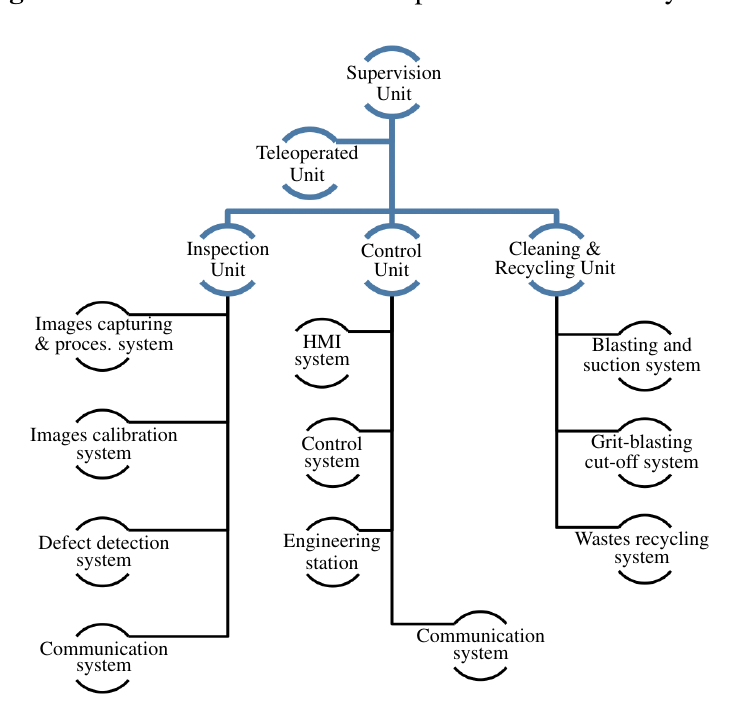
Figure 8. Elements of the visual inspection and control